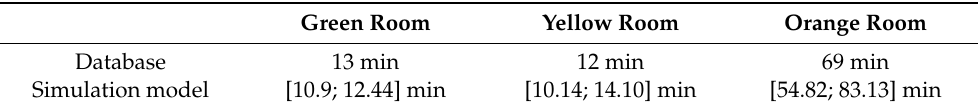
Table 3. Takt time comparison between values obtained by the database and by simulation model.